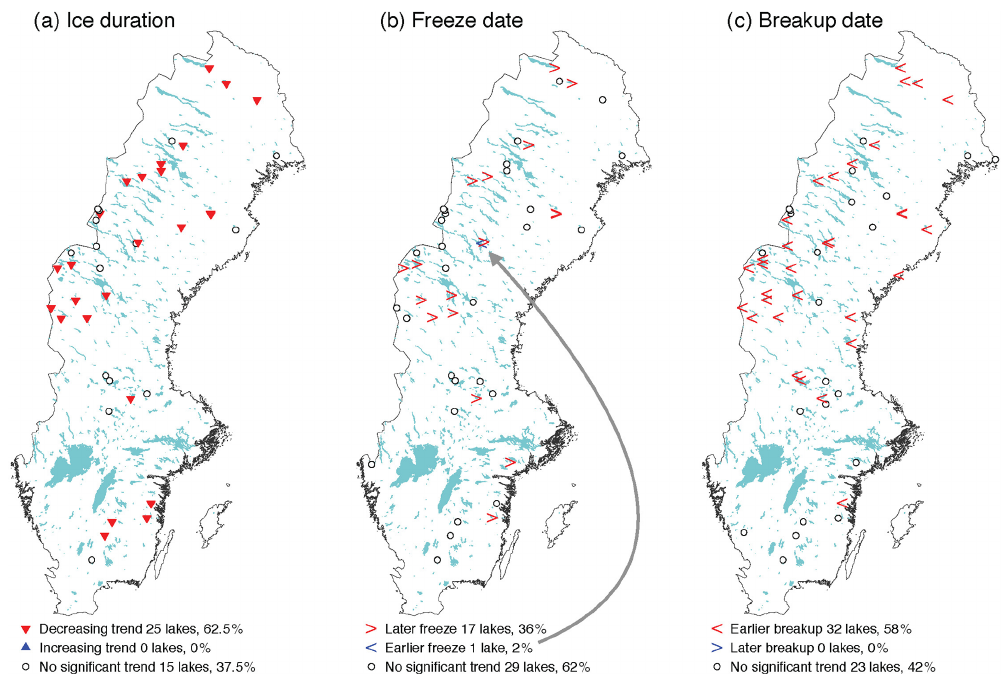
Figure 3. Trends in (a) ice duration, (b) freeze date, and (c) break-up date during 1913–2014. The number of water bodies and the corre- sponding percentages of observation locations with statistically significant ( p < 0 . 05) or insignificant trends are